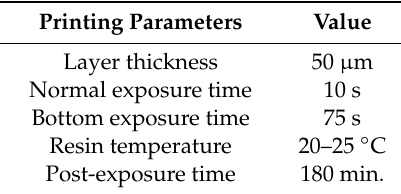
Table 1. Printing parameters for SLA 3D printer.